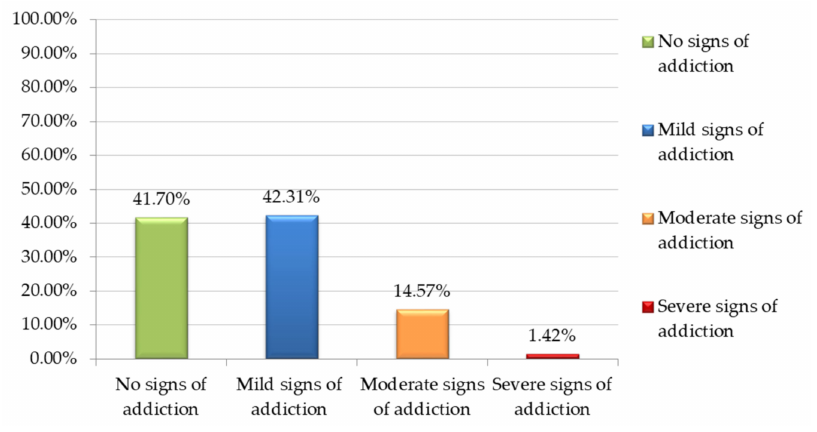
Figure 2. Level of internet